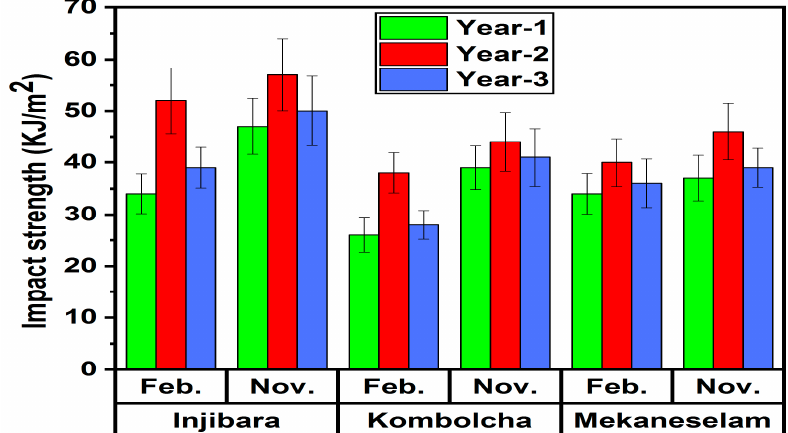
Figure 12. Impact strength of bamboo fibre polypropylene composite in Ethiopia.